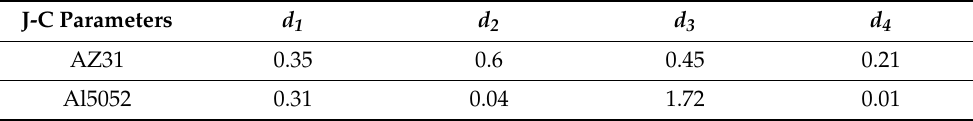
Table 3. Johnson–cook damage parameters for the AZ31 and Al5052 alloys [28,29].